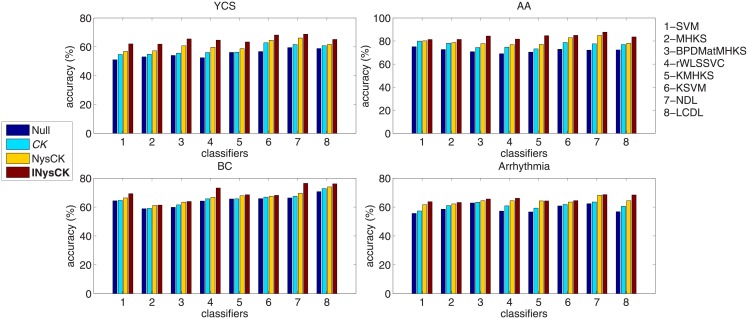
Accuracy with related classifiers and CK-based methods on used single-view data sets.CK-related method in italic represents baseline one and one in bold denotes the proposed one. For classifiers, SVM is used as the baseline one and we just clarify this point in words rather than in font. In other figures and tables, we have similar representations.